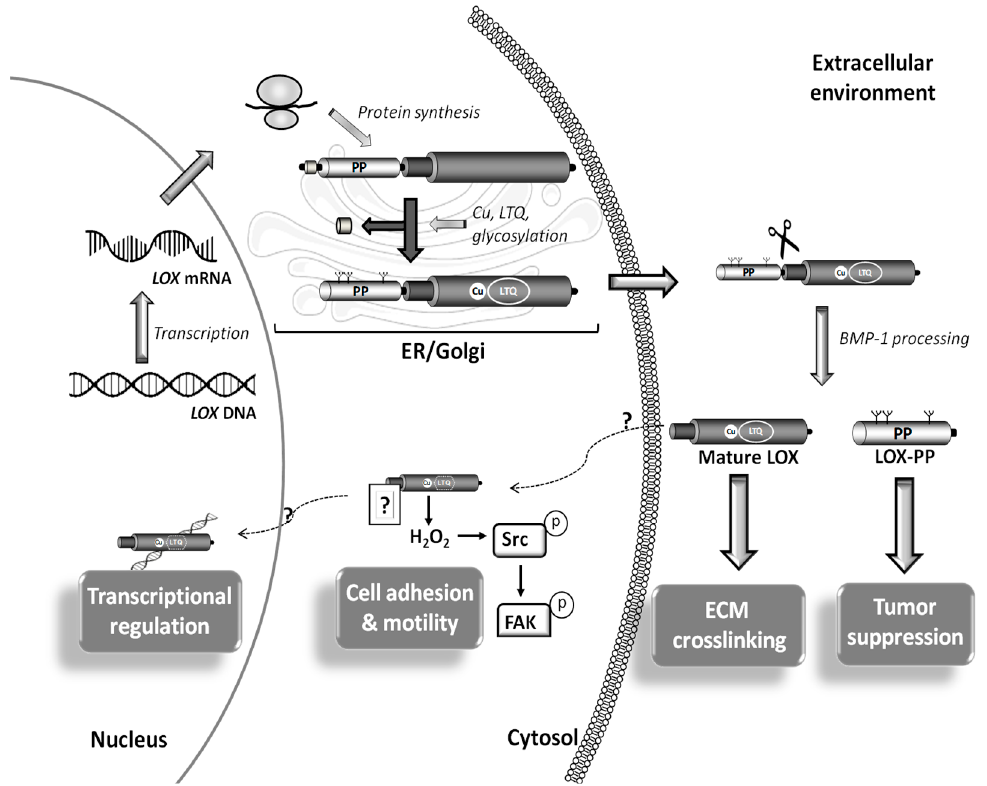
Figure 3. Synthesis and processing of LOX. LOX is transcribed and transduced leading to the production of the pre-proLOX form, a pre-proenzyme which is post-translationally modified in endoplasmic reticulum (ER) and Golgi to generate the LOX proenzyme. This multistep process involves (i) cleavage of signal peptide, (ii) incorporation of copper, (iii) formation of the lysyl tyrosyl quinone (LTQ) cofactor and (iv) glycosylation of the LOX propeptide region (LOX-PP). Then this inactive precursor is released into the extracellular space, where it is proteolyzed by procollagen C-proteinases (mainly bone morphogenetic protein 1; BMP1) producing the mature catalytic LOX form, which promotes extracellular matrix (ECM) maturation, and its pro-peptide, which is responsible of the tumor suppressor properties of LOX among others effects. Intracellular forms of mature LOX have also been detected in cytosol and nuclei. In cancer cells, cytosolic active LOX forms control cell adhesion and motility through the H 2 O 2 -dependent activation of Src-kinase and the subsequent phosphorylation of focal adhesion kinase (FAK). Likewise, nuclear LOX modulates chromatin structure affecting gene expression.